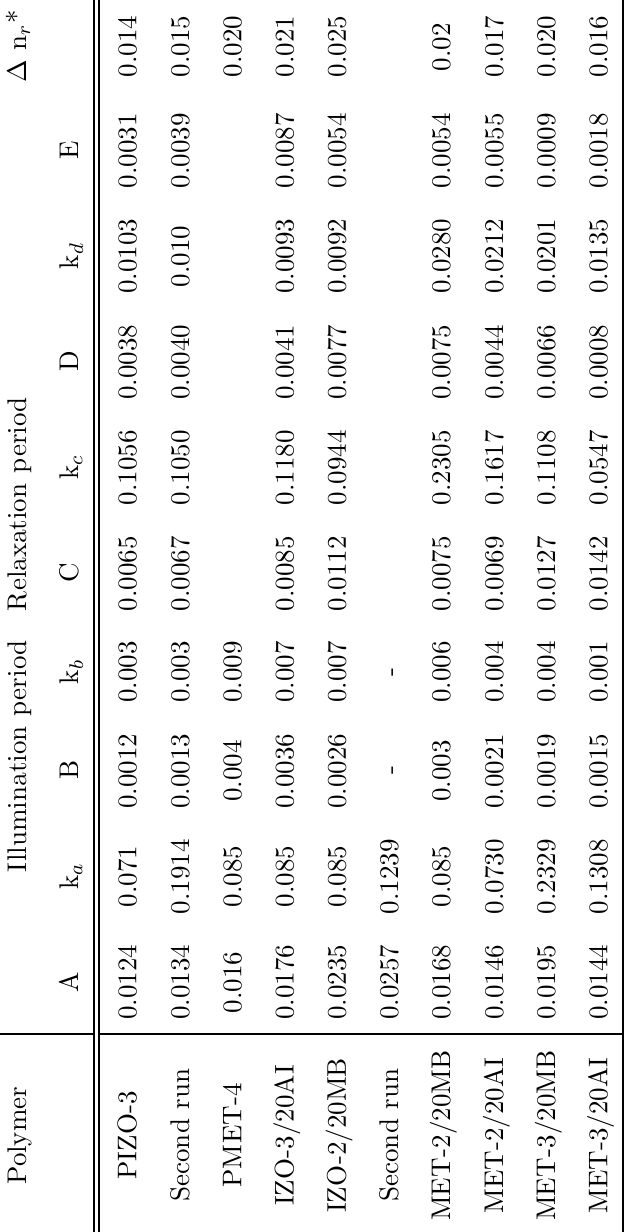
0 ¡ n photostat: ; r = n r r